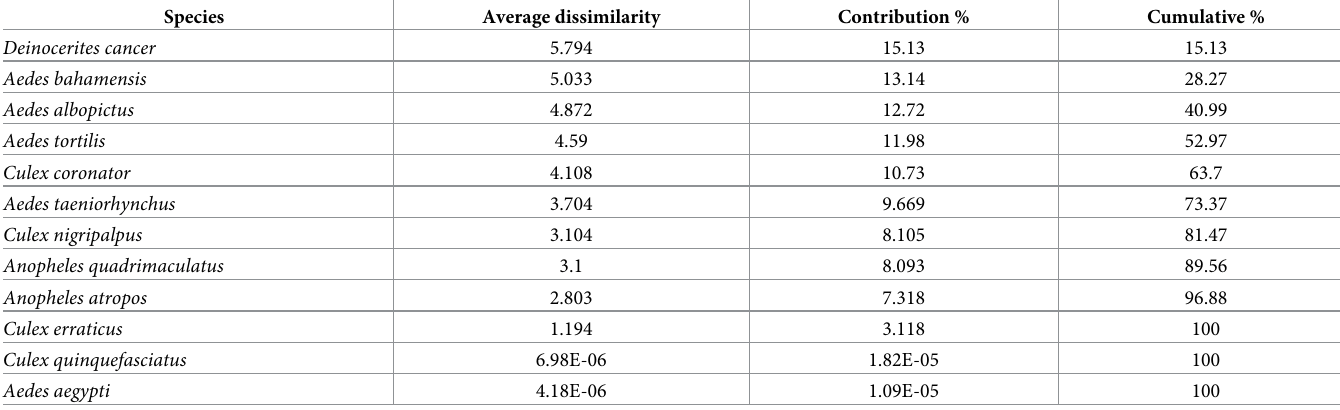
Table 2. SIMPER (Similarity Percentage) analysis of which species contributed the most to the observed differences comparing maritime entry ports in Miami- Dade County,